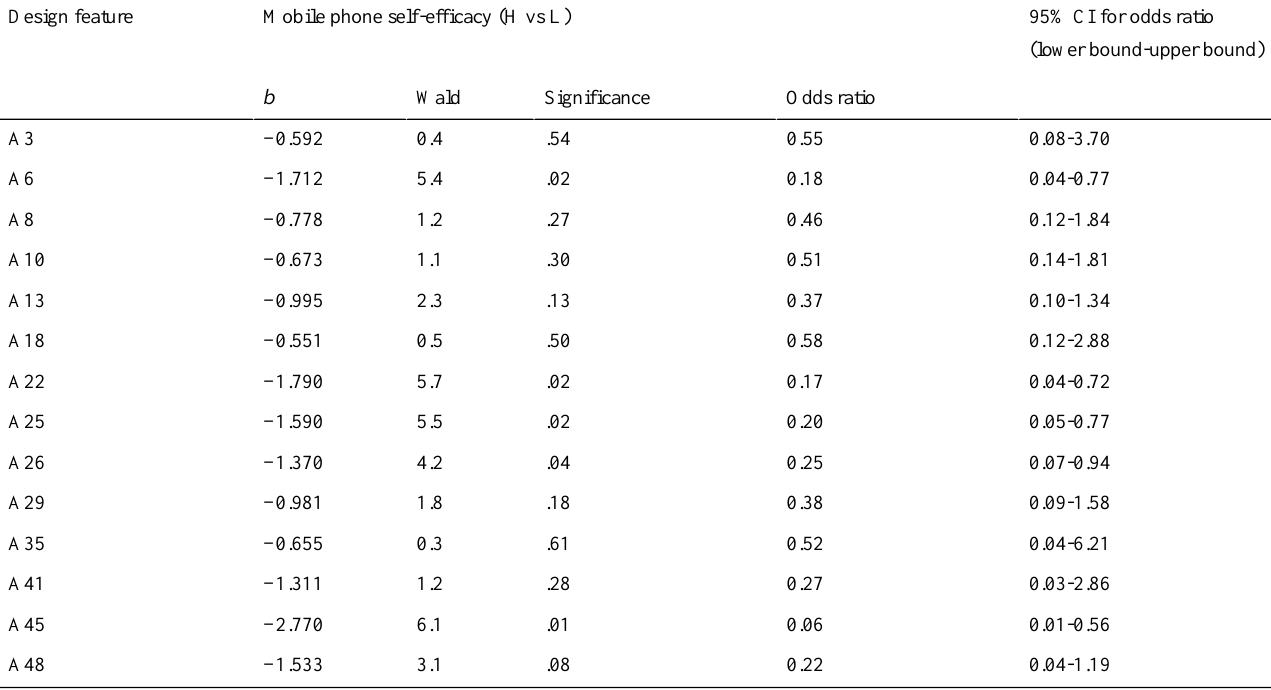
Table 12. Parameter estimates of change of mobile phone self-efficacy (MPSE) from medium to low ( must-be over indifferent ).